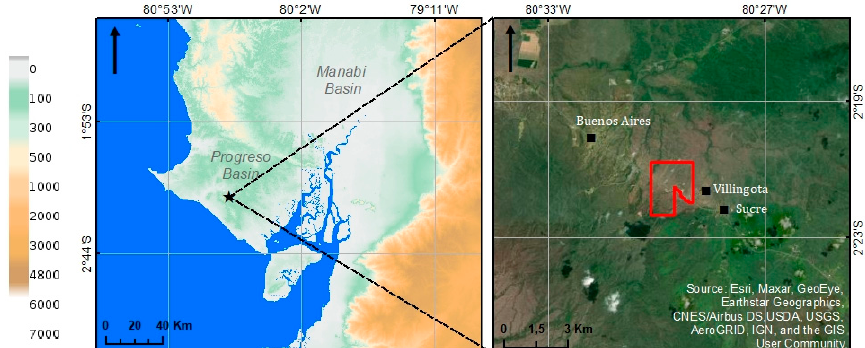
Figure 1. Location map of the study area in Santa Elena Province, Ecuador. Universal Transverse Mercator Projection (WGS 84—17S). Elevation data and satellite image information from Instituto Geográfico Militar (http://www.geoportaligm.gob.ec/dtm/wms (accessed on 28 February 2022), Esri, Maxar, Geoeye, Earthstar geographics, CNES/Airbus DS, USDA, USGS, AeroGRID, IGN, and the GIS User Community.